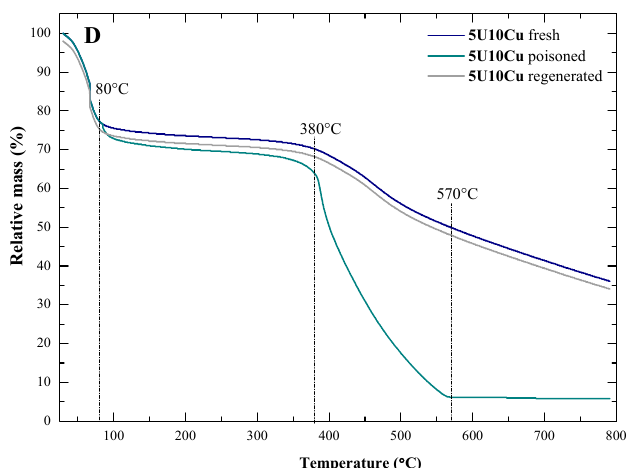
Figure 3. Results of thermogravimetric analysis obtained for fresh, poisoned, and regenerated: ( A ) 5U; ( B ) 5U1Cu; ( C ) 5U5Cu; ( D )